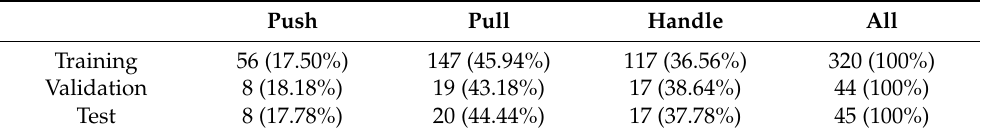
Table 5. Distribution of images per class for each partition for images without human demonstration. Push Pull Handle All Training 56 (17.50%) 147 (45.94%) 117 (36.56%) 320 (100%) Validation 8 (18.18%) 19 (43.18%) 17 (38.64%) 44 (100%) Test 8